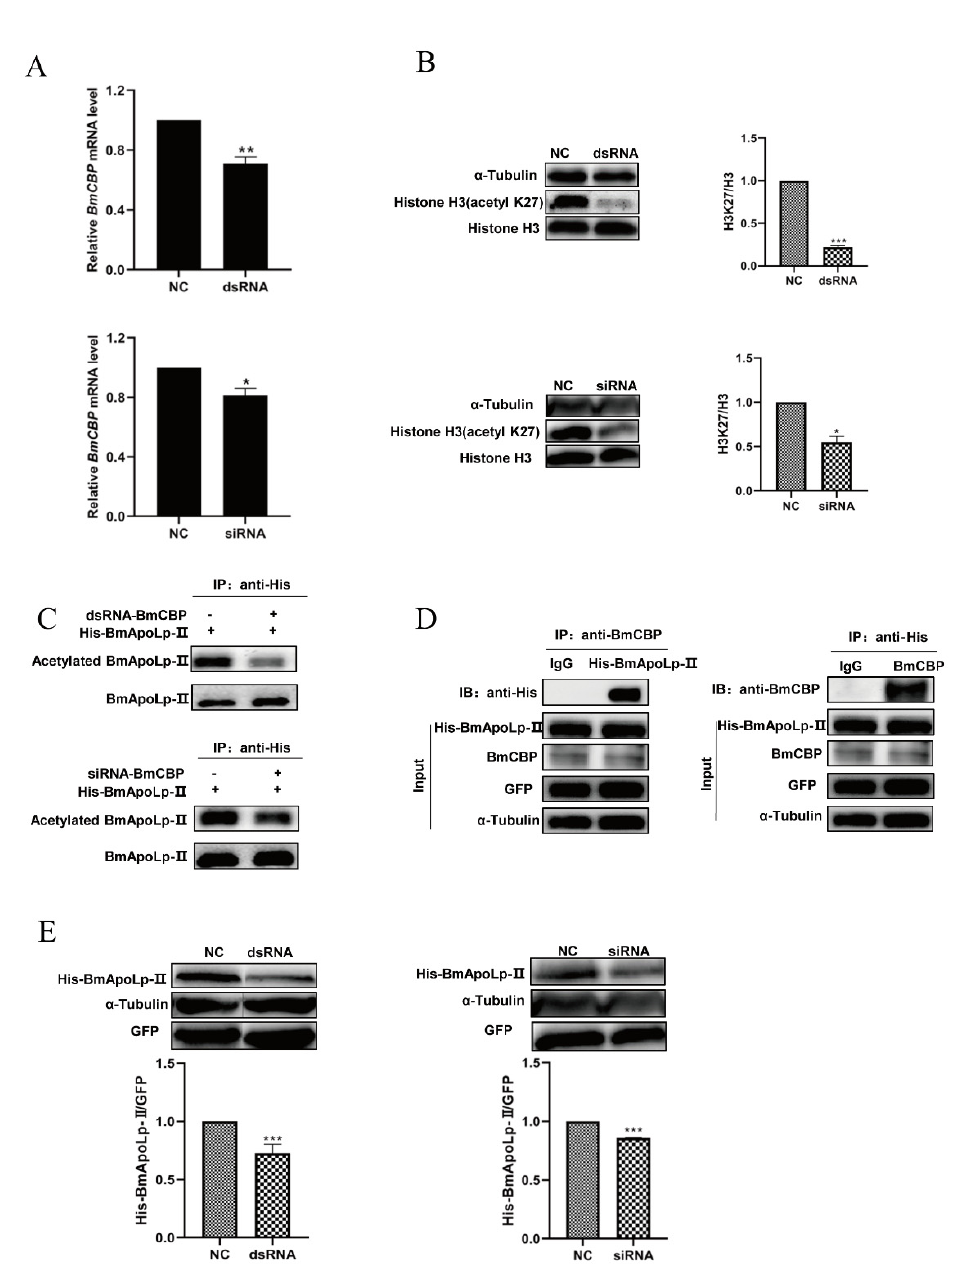
Figure 4. BmCBP interacts with BmApoLp-II protein and catalyzes its acetylation. ( A ) After dsRNA or siRNA transfection, the mRNA level of BmCBP gene in the cells was significantly down- regulated to some extent. ( B ) Compared with the protein level of α -tubulin/Histone H3, the acety- lation level of H3K27 was down-regulated at 48 h after transfection of dsRNA or siRNA. ( C ) The acetylation level of the BmApoLp-II protein was significantly down-regulated by RNA interference using dsRNA or siRNA. “+” means existence, “-” means no existence. ( D ) The interaction between endogenous BmCBP protein and overexpressed His-BmApoLp-II protein in silkworms. ( E ) After co-transfection of dsRNA or siRNA, the expression of the BmApoLp-II protein in BmN cells was significantly down-regulated. The data represent the results of at least three independent experiments. * p < 0.05, ** p < 0.01, *** p < 0.001. The effect of RNAi using dsRNA was significantly more effective than that of RNAi using